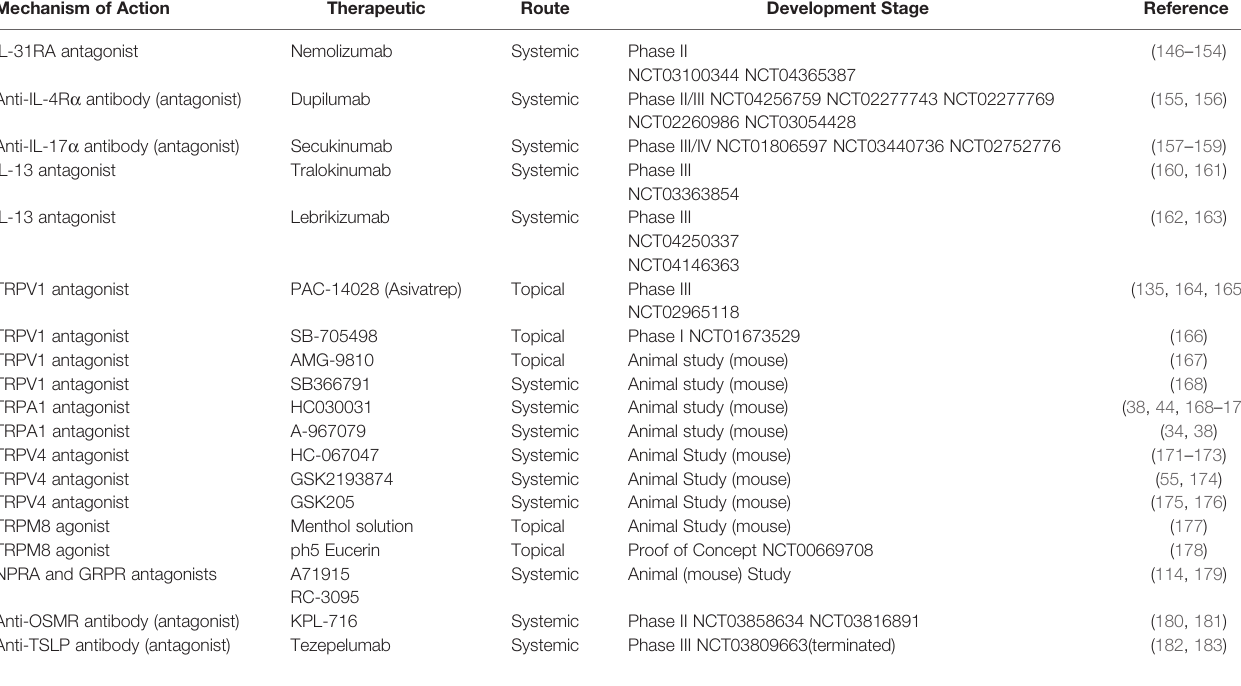
TABLE 2 | Overview of Th-cytokine pathway-related and TRP channel-based anti-pruritic therapeutics investigated in both animal and clinical trials (Data are based on the ClinicalTrials.Gov 2021). Mechanism of